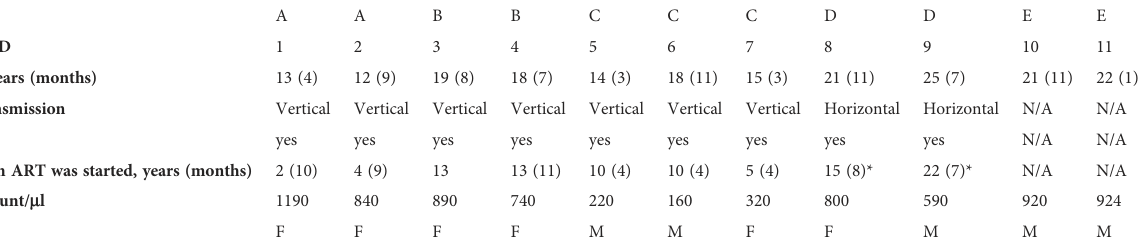
TABLE 1 Patient